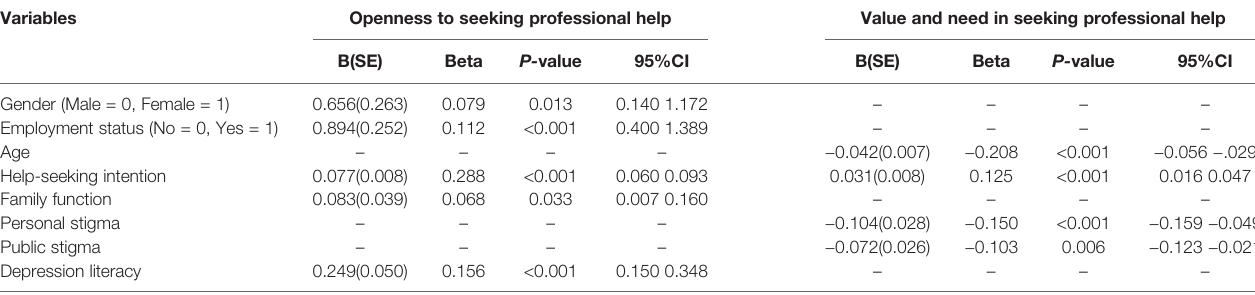
TABLE 5 | Correlates of attitudes toward seeking professional psychological help (ATSPPH) conducted by multiple linear